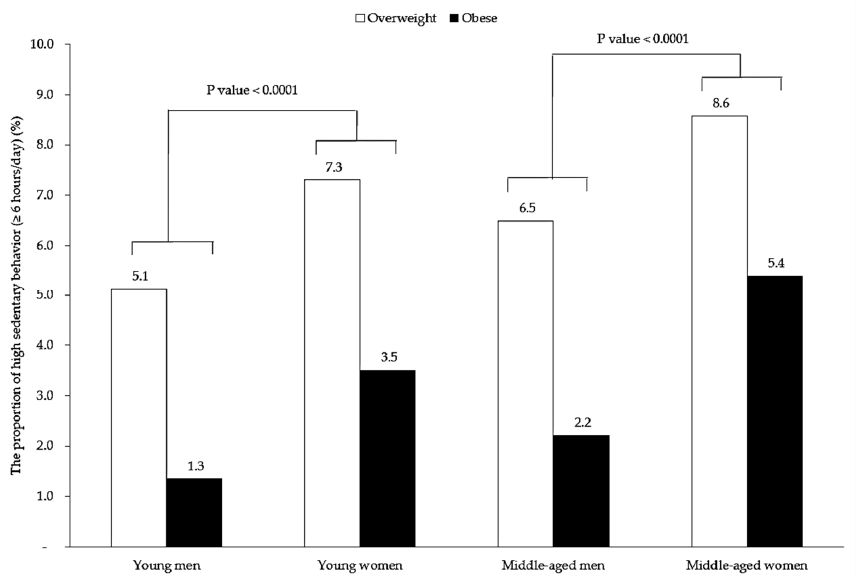
Figure 3. The proportion of high sedentary behaviors by gender and age.